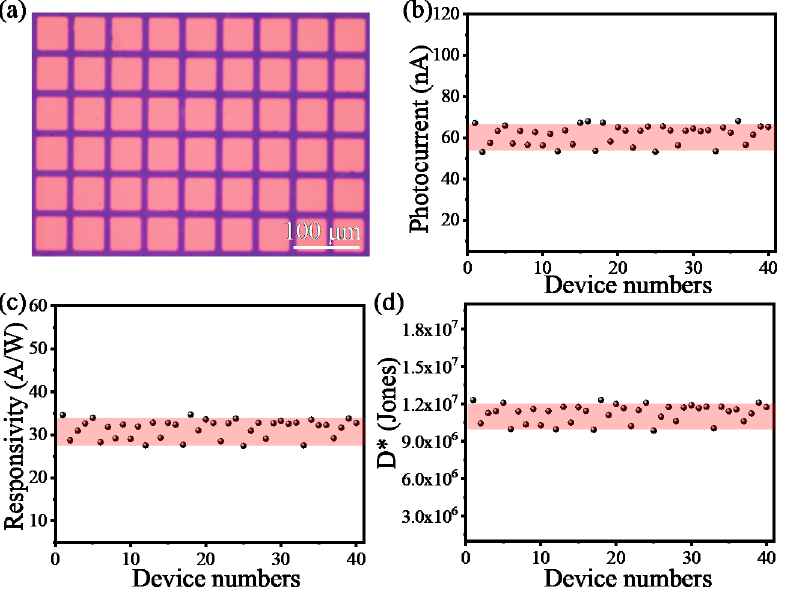
Figure 5. Large area uniformity of PtS 2 array FETs. ( a ) The OM image of PtS 2 array FETs on SiO 2 /Si substrate. ( b – d ) Statistical I ph ( b ), R ( c ), and D * ( d ) of PtS 2 array FETs at 40 randomly selected electrodes under 1550 nm laser illumination in air conditioning with V ds = 2.0 V.